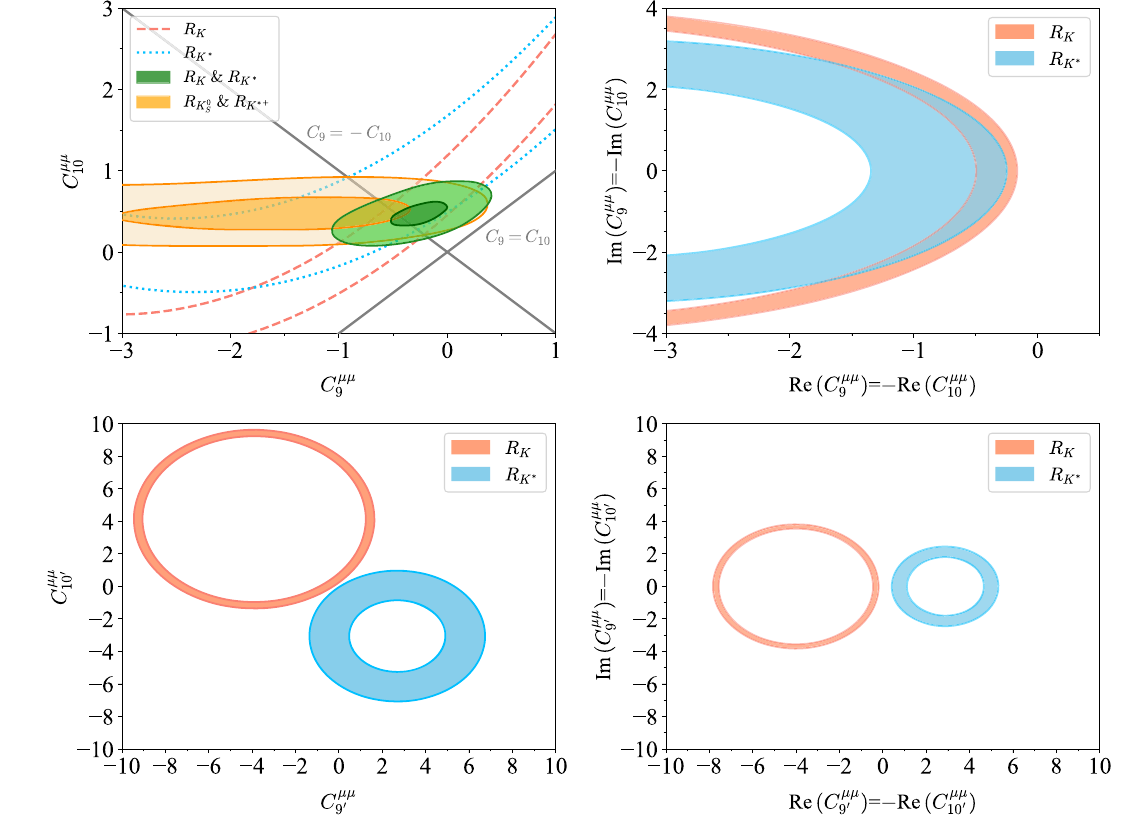
μμ μμ = − C μμ spondstothecomplexplaneof C ,with C assumed.The 9 , 10 9 10 μμ orange and blue regions represent the 1 σ allowed regions that explain 9 R K and R K ∗ , respectively. Bottom: Left panel shows the fit to R K ( ∗ ) μμ μμ using C and C as real parameters, while right one corresponds to 9 (cid:6) 10 (cid:6) μμ = − C μμ . the fit using complex parameters with the assumption C 9 (cid:6) 10 (cid:6) μμ μμ No overlap region indicates that C and C can not 9 (cid:6) 10 (cid:6)